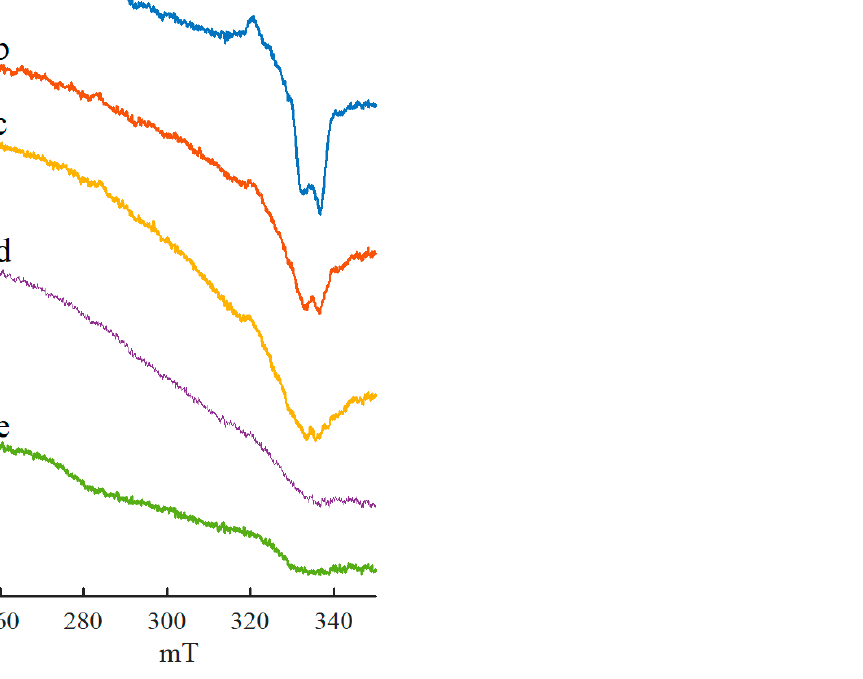
Figure 7. EPR spectra of the Co(acac) 2 –AlEt 3 catalytic system formed in toluene in a argone atmosphere in the presence of: ( a – d ) 1-hexene, ( e ) styrene; ( a , e ) 0.1–0.5 min, ( b ) 1–3 min, ( c ) 3–5 min, ( d ) 5–7 min after mixing the components. Spectra were obtained under identical conditions.